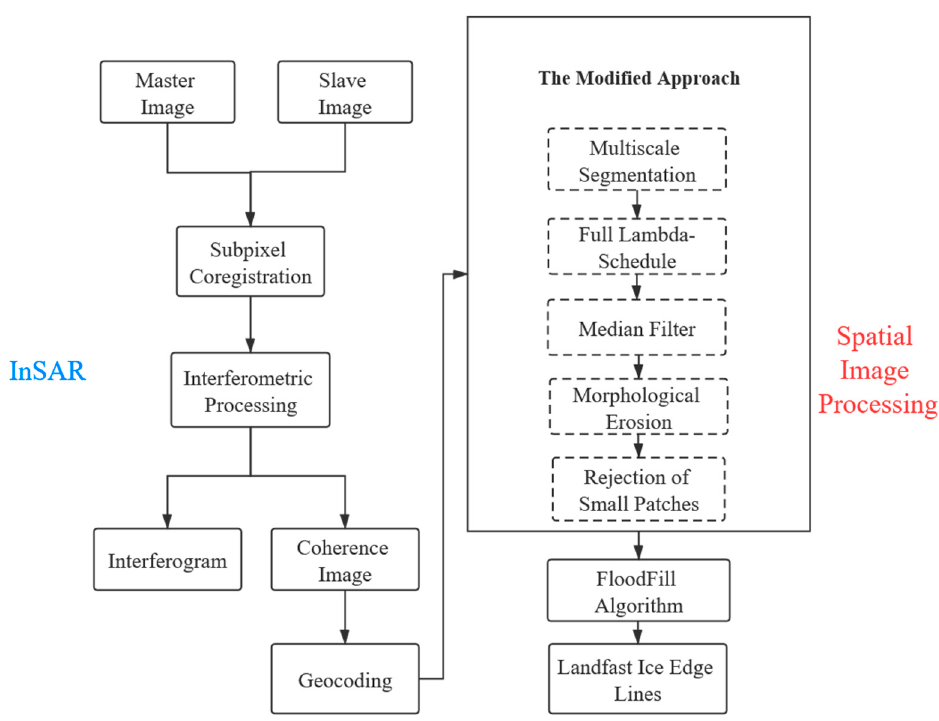
Figure 2. Methodology workflow used for extracting the landfast ice edge lines in this paper.